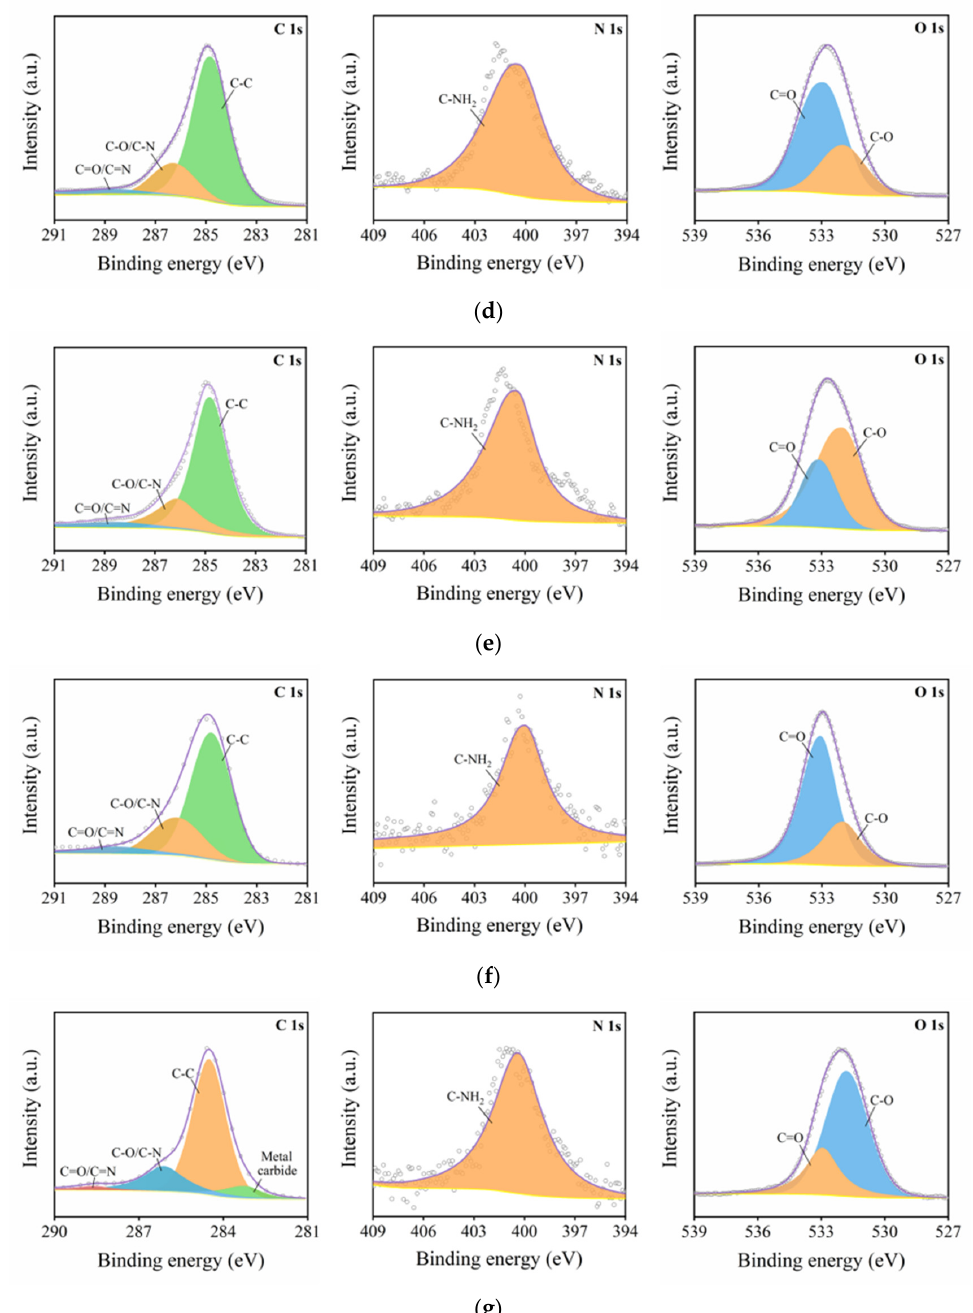
Figure 17. Peak separation fitting diagram of C 1 s, N 1 s and O 1 s on CF/EP sample surface before plasma treatment and with different plasma treatment times. ( a ) Untreated, ( b ) sandblasting treatment, ( c ) plasma treatment for 5 s, ( d ) plasma treatment for 10 s, ( e ) plasma treatment for 25 s, ( f ) plasma treatment for 60 s and ( g ) sandblasting and plasma treatment for 25